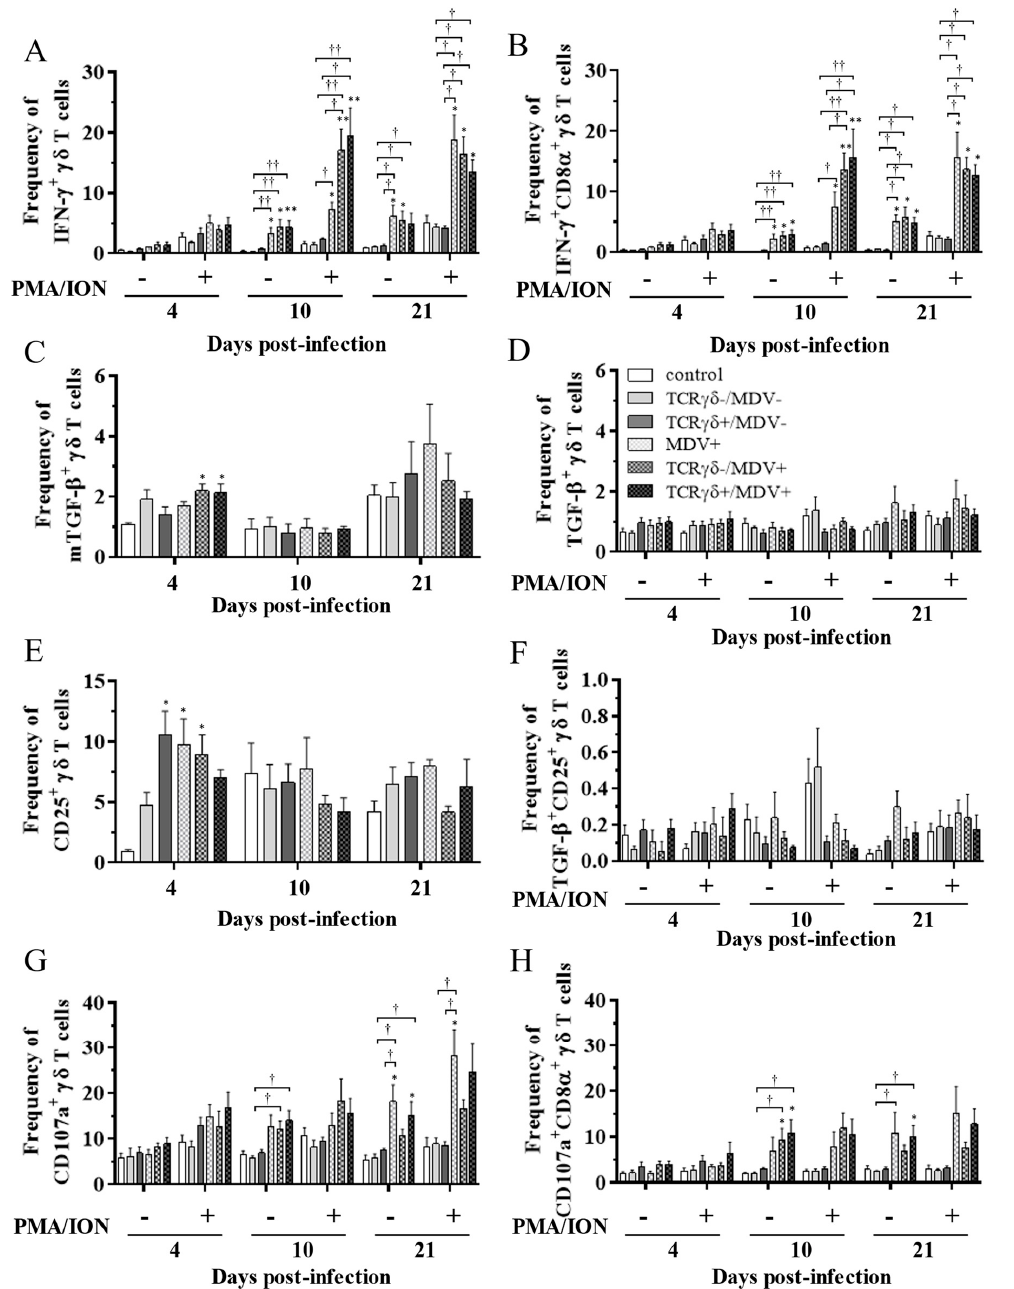
Figure 9. Cytokine and immune system molecule profiles in γδ T cells derived from the lungs at 4, 10, and 21 dpi. Mononuclear cells isolated from the lungs of the control, the TCR γδ‐ /MDV ‐ , the TCR γδ +/MDV ‐ , the MDV+, the TCR γδ‐ /MDV+, and the TCR γδ +/MDV+ groups were cultured with and without PMA/ION for 4 h. Percentages of IFN ‐γ + γδ T cells ( A ), IFN ‐γ + CD8 α + γδ T cells ( B ), mTGF ‐β γδ T cells ( C ), TGF ‐β γδ T cells ( D ), CD25 + γδ T cells ( E ), TGF ‐β + CD25 + γδ T cells ( F ), CD107a + γδ T cells ( G ), and CD107a + CD8 α + γδ T cells ( H ) within γδ T cell populations in the lungs collected from each group at 4, 10, and 21 dpi are shown. Data represent the mean of 5 biological replicates ± SE in each group at each time point. Significant differences are indicated by *: p < 0.05 (vs. control), **: p < 0.01 (vs. control), †: p < 0.05, and ††: p < 0.01.